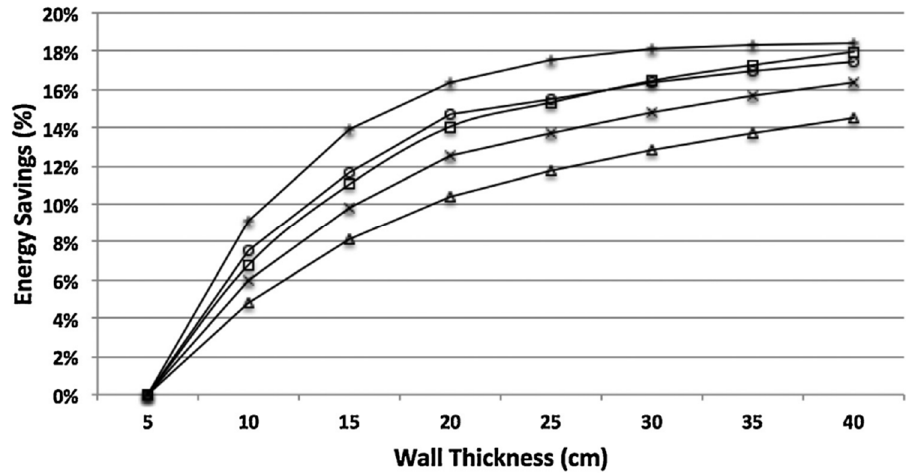
Figure 1. Total annual energy consumption, space cooling and space heating for a villa located in five KSA cities [9].